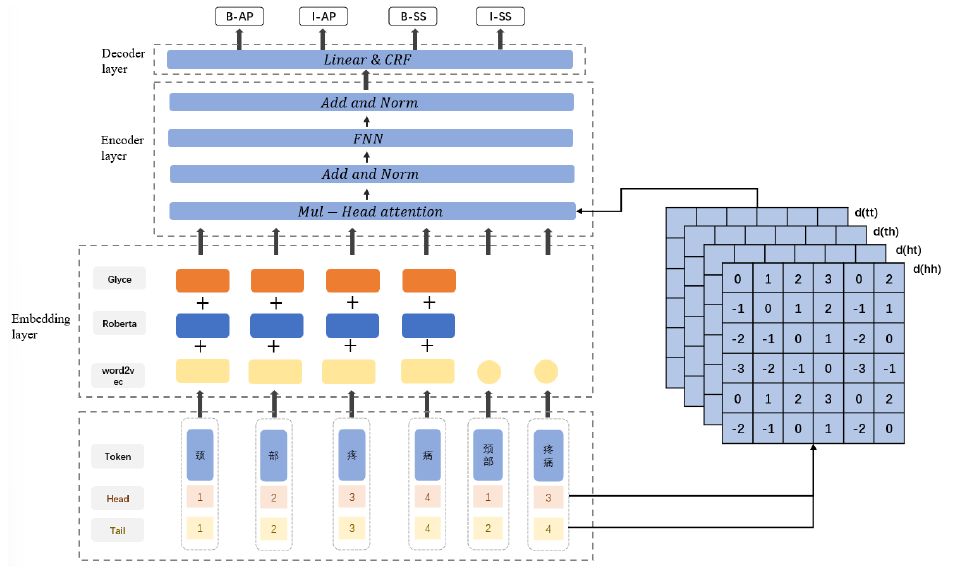
Figure 1. Model structure diagram of RG-FLAT-CRF.